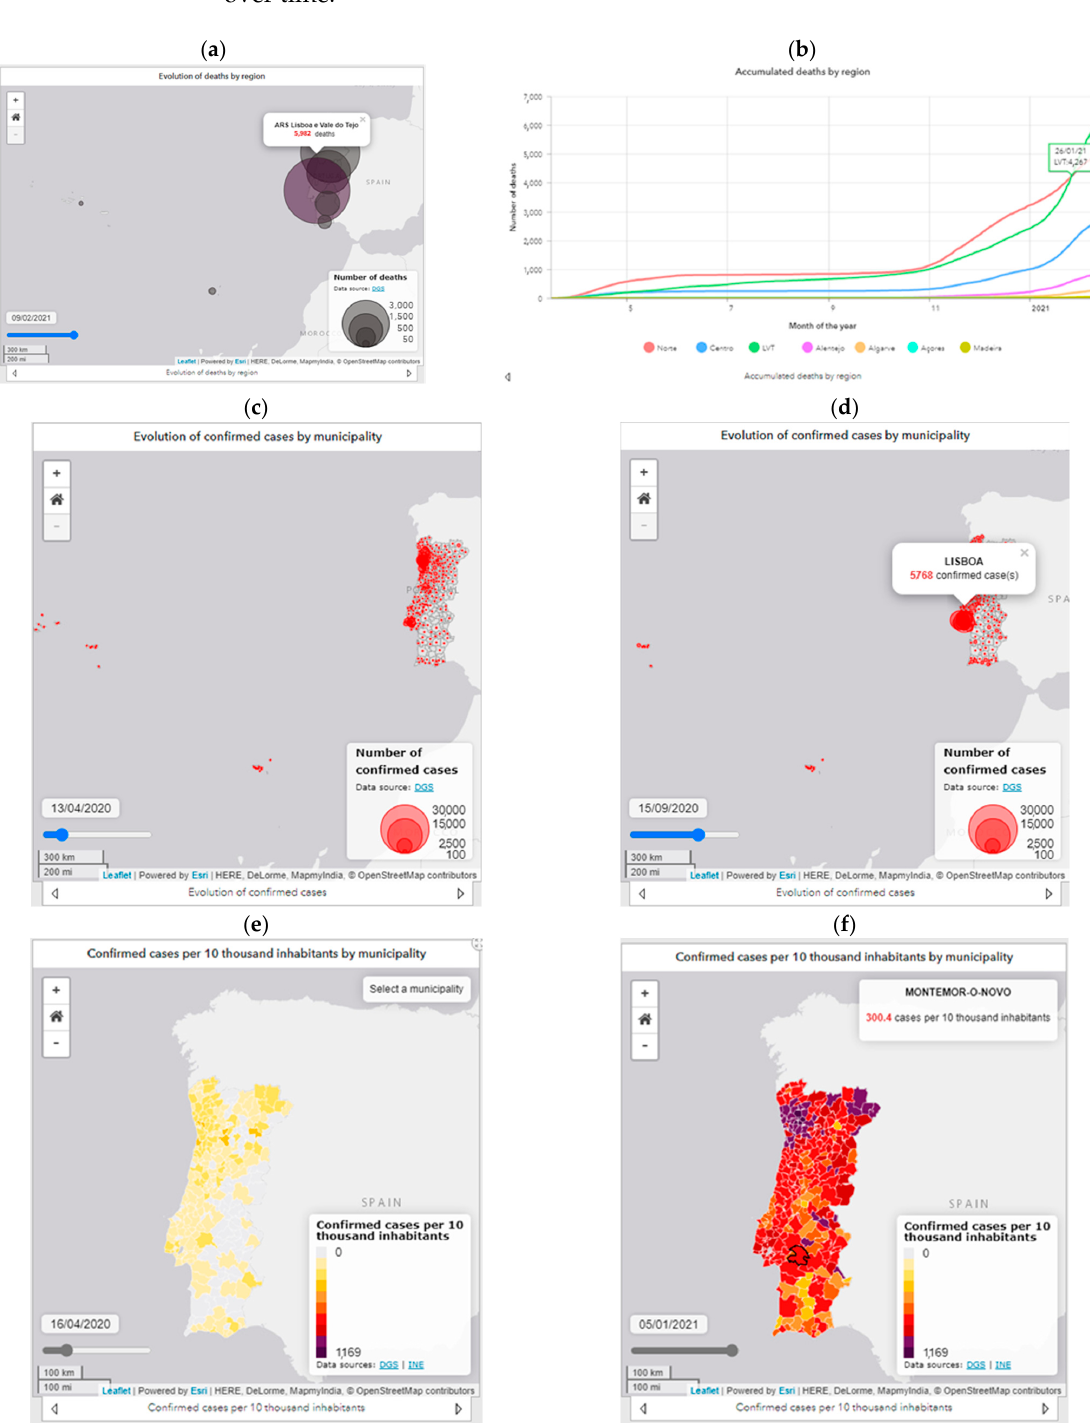
Figure 4 - Interactivity of the dashboard elements. Source: https://www.comprime-compri-mov.com (accessed on 9 February 2021).